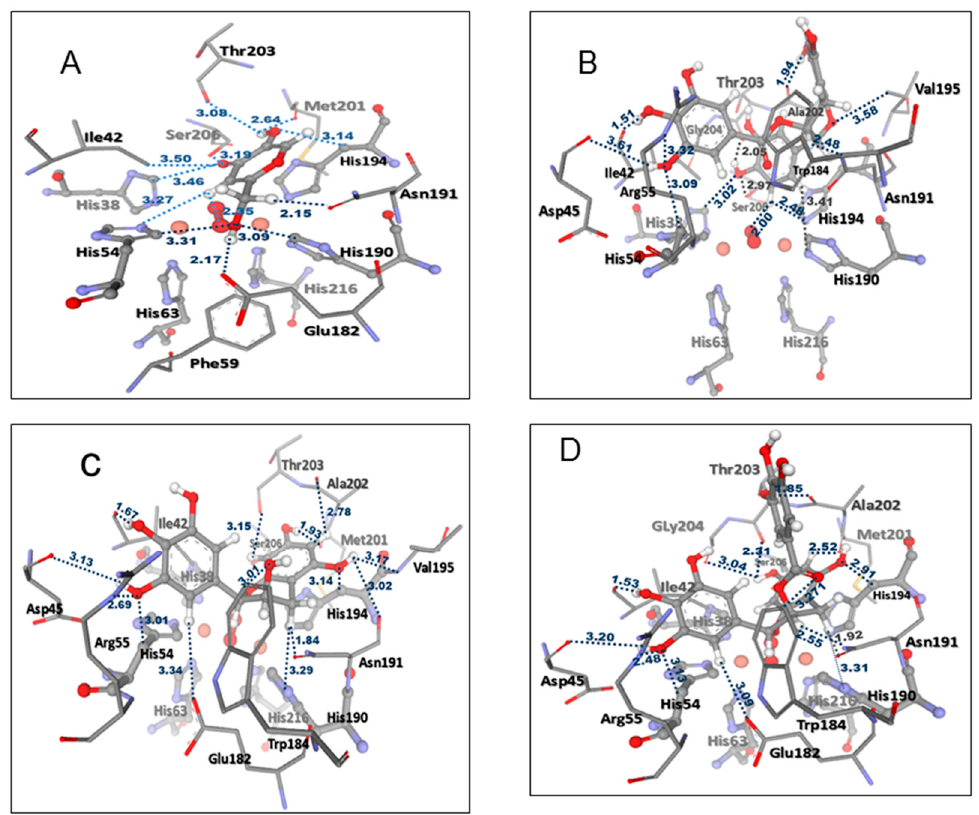
Figure 8. The distances (in Å) between the residues in the tyrosinase-binding pocket and ligands: ( A ) KA; ( B ) ECG; ( C ) EGC; and ( D ) EGCG. Oxygen, nitrogen, carbon, hydrogen, sulfur, and copper atoms are presented in red, violet, grey, white, yellow, and orange color, respectively.